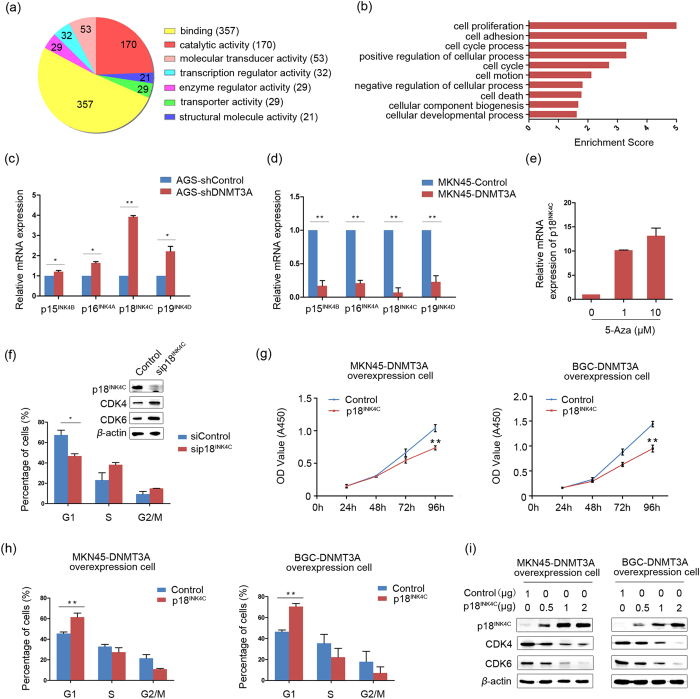
p18INK4C participates in DNMT3A-induced cell proliferation.(a) The pie chart shows the top seven most significantly enriched molecular function gene ontology (GO) terms. (b) The bar plot shows the top ten most significantly enriched biological process GO terms and their scores. Count, the number of differentially expressed genes associated with the listed GO ID. Enrichment Score, the GO ID enrichment score, which equals (−log10 (P-value)). (c,d) Relative mRNA expression of INK4 members was detected in DNMT3A knockdown AGS cells or in DNMT3A overexpression MKN45 cells by qPCR. β-actin was used as an internal control (*P < 0.05, **P < 0.01). (e) The mRNA expression of p18INK4C was detected in DNMT3A overexpression MKN45 cells after treatments with different doses of 5-Aza. (f) Flow cytometry analysis of the distribution of cell cycle phases after treatment of GC cells with sip18INK4C. The percentages of cells in the G1, S, and G2/M phases are shown in the bar chart as the mean ± SD of three independent experiments (*P < 0.05). After the silencing of p18INK4C by treatment with sip18INK4C, the protein expression levels of CDK4 and CDK6 were increased. β-actin was used as a loading control. (g) CCK-8 analysis of cell proliferation in DNMT3A overexpression MKN45 and BGC-823 cells transiently transfected with a p18INK4C construct and control vector. The cell growth rates are shown as the mean ± SD of three independent experiments (**P < 0.01). (h) Flow cytometry analysis of cell cycle phases in DNMT3A overexpression MKN45 and BGC-823 cells transiently transfected with a p18INK4C construct and control vector. The percentages of cells in the G1, S, and G2/M phases are shown as the mean ± SD of three independent experiments (**P < 0.01). (i) Transient transfection of p18INK4C into DNMT3A overexpression MKN45 and BGC-823 cells led to dose-dependent downregulation of CDK4 and CDK6, as determined by western blotting. β-actin was used as a loading control.